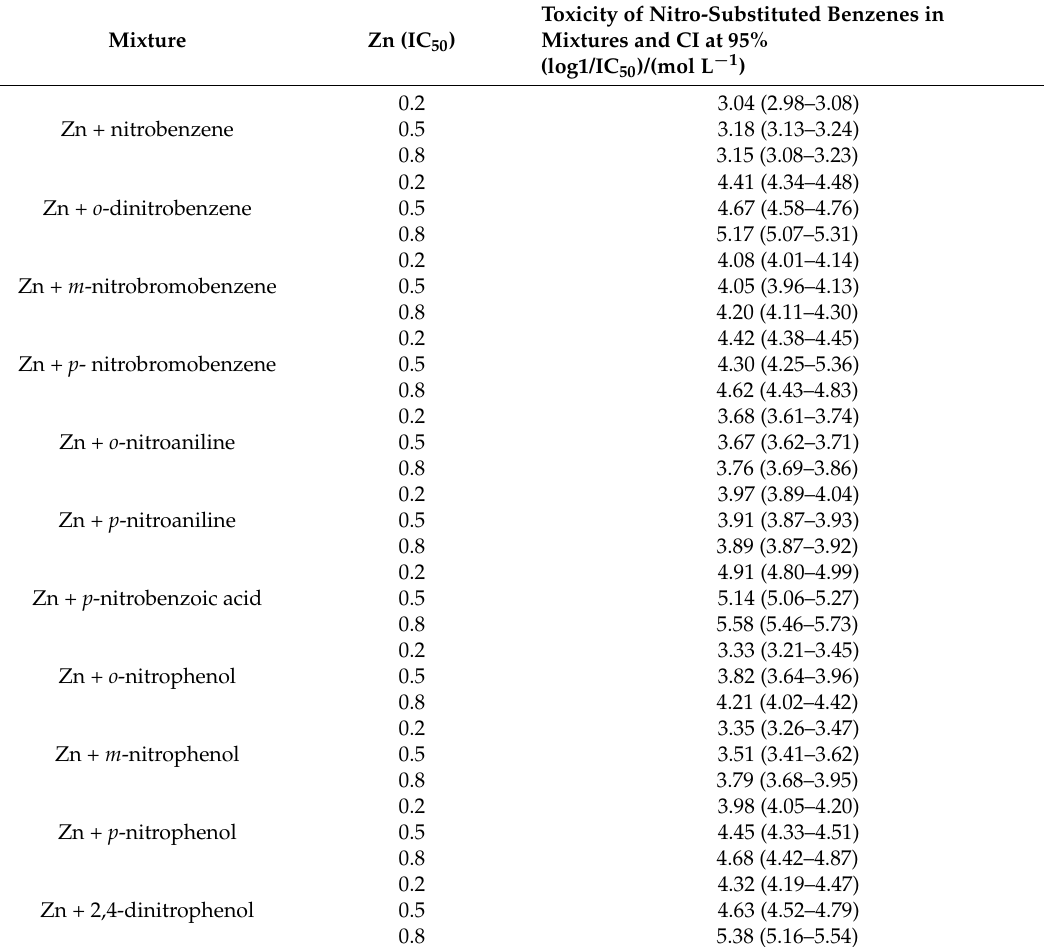
Table 3. Toxicity of nitro-substitutions and